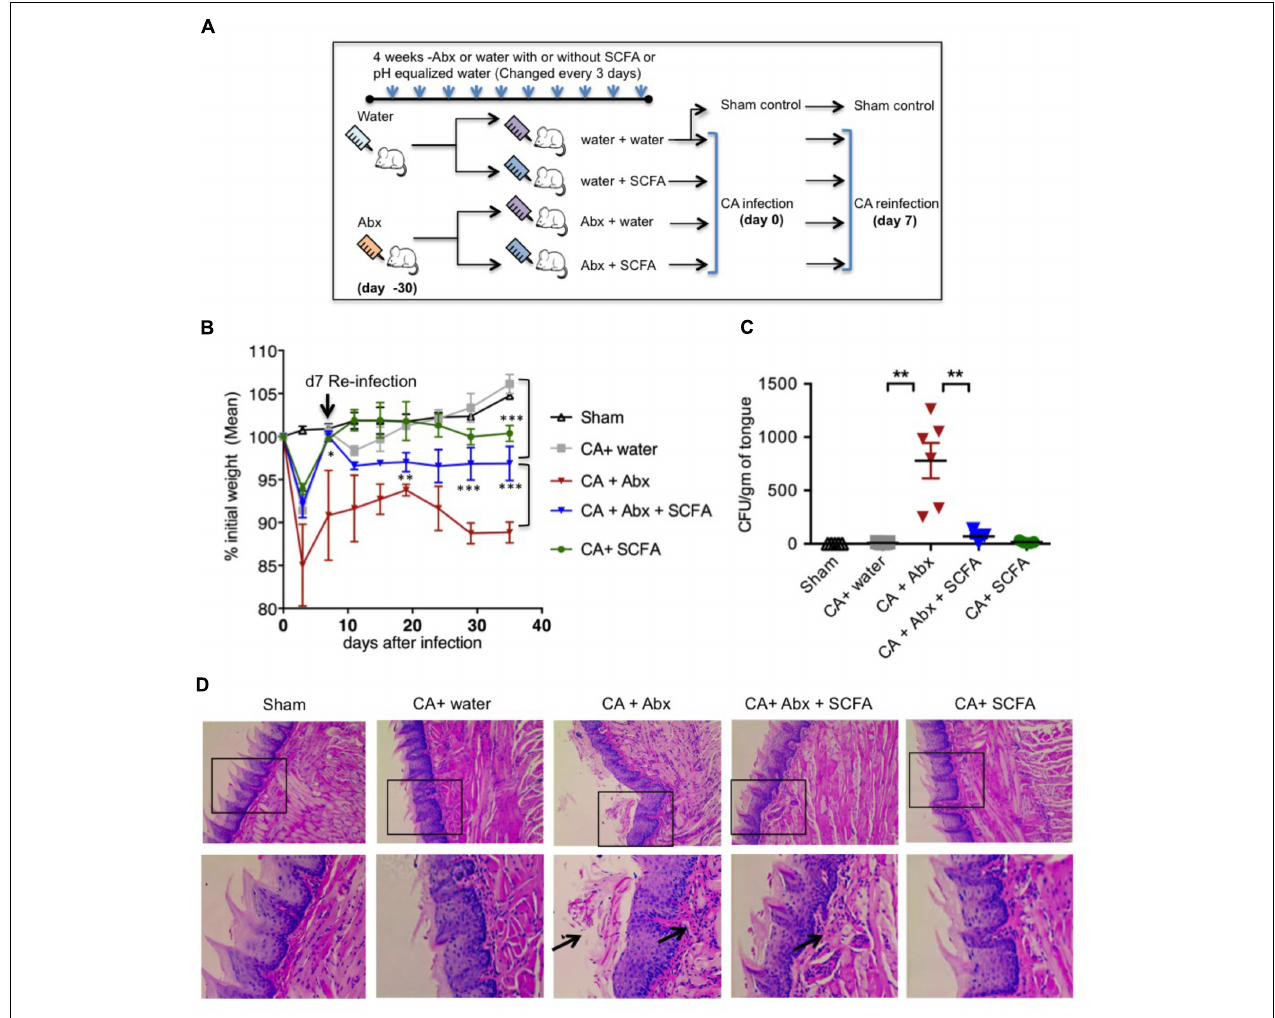
FIGURE 1 | Abx treatment results in impaired resistance to OPC in mice, while SCFAs reduce fungal burden and immunopathology. (A) Abx and SCFA administration schedule. Abx, antibiotics; SCFA, short chain fatty acids. (B) Abx or SCFA treated C57BL/6 mice were orally infected and re-infected with C. albicans (CA) n = 4/group. Body weight was measured every 3rd day until the day of sacrifice. (C) On day 28 or 29 after secondary infection, we re-infected the mice. Three days after 2nd re-infection, we isolated the tongue, and determined the fungal growth, by plating the tongue lysates in Sabaroud dextrose agar. Fungal Colony Forming Units (CFU)/gm of tongue tissue plated in 10-fold serial dilutions and assessed in triplicates. Mean values ± SEM are plotted. (D) Three days after 2nd re-infection, we fixed the intact tongues and performed PAS staining and microscopic examination (200 × magnification). Bottom panels show magnified images of respective upper panels. Data are representative of at least four experiments. ∗ P < 0.05, ∗∗ P < 0.005, and ∗∗∗ P <